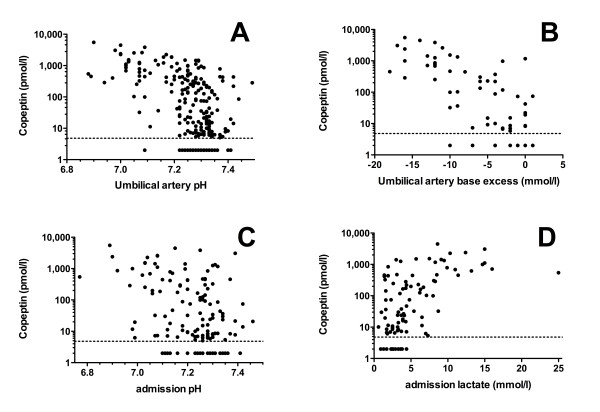
Copeptin concentration correlates with perinatal acidosis. Copeptin cord blood concentrations are plotted against umbilical artery pH (A, n = 236), umbilical artery base excess (B, n = 60), pH at admission to the NICU (C, n = 138) and lactate concentration at admission to the NICU (D, n = 100). The dotted line indicates the detection limit (4.8 pmol/l).